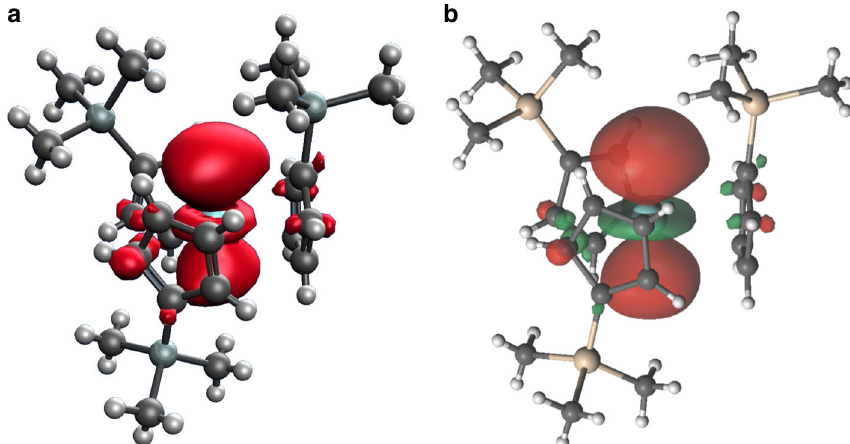
Fig. 4 The calculated electronic structure of the anion in 1 . This shows: a spin density from DFT; b the SOMO (natural orbital for the ground S = 1/2 state) from CASSCF